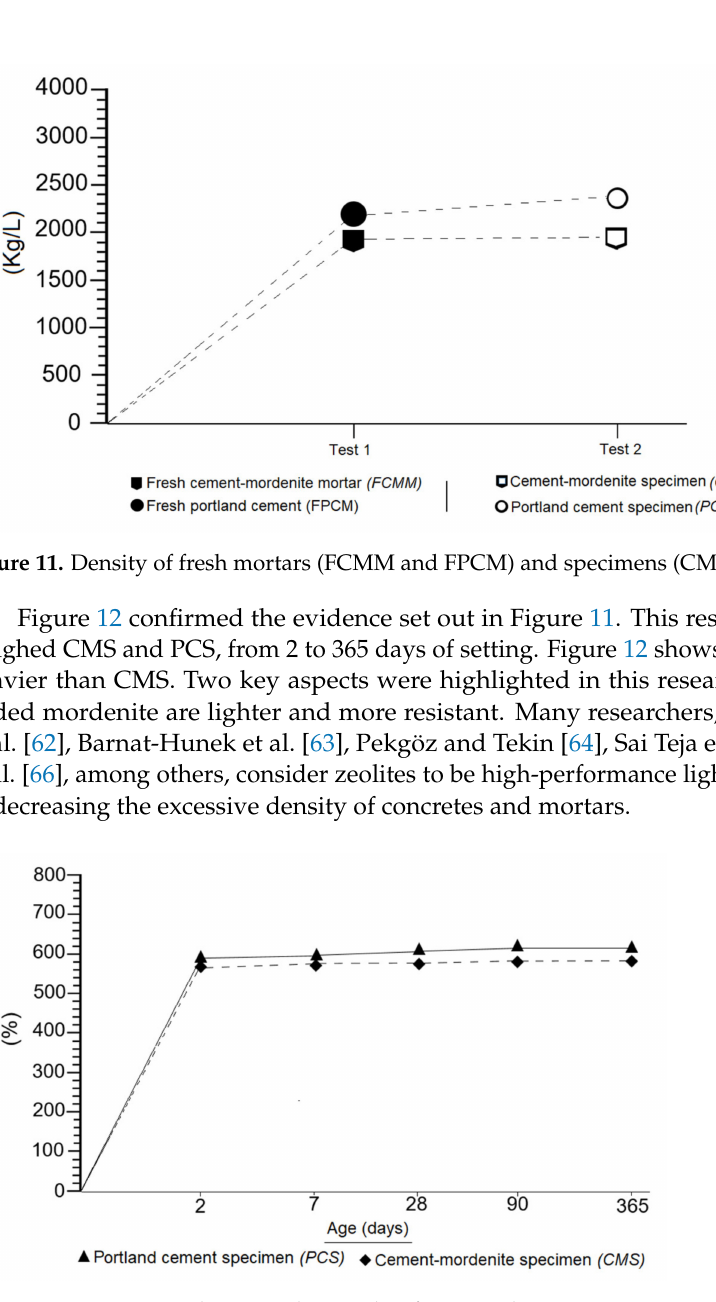
Figure 12. Comparison between the weight of CMS and PCS